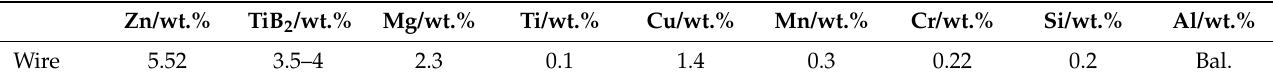
Table 1. Chemical composition of 7075 aluminum alloy welding wire (%, mass